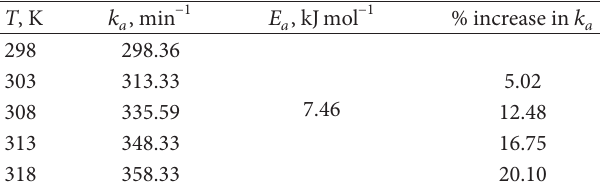
T 5: Effect of temperature on adsorption rate